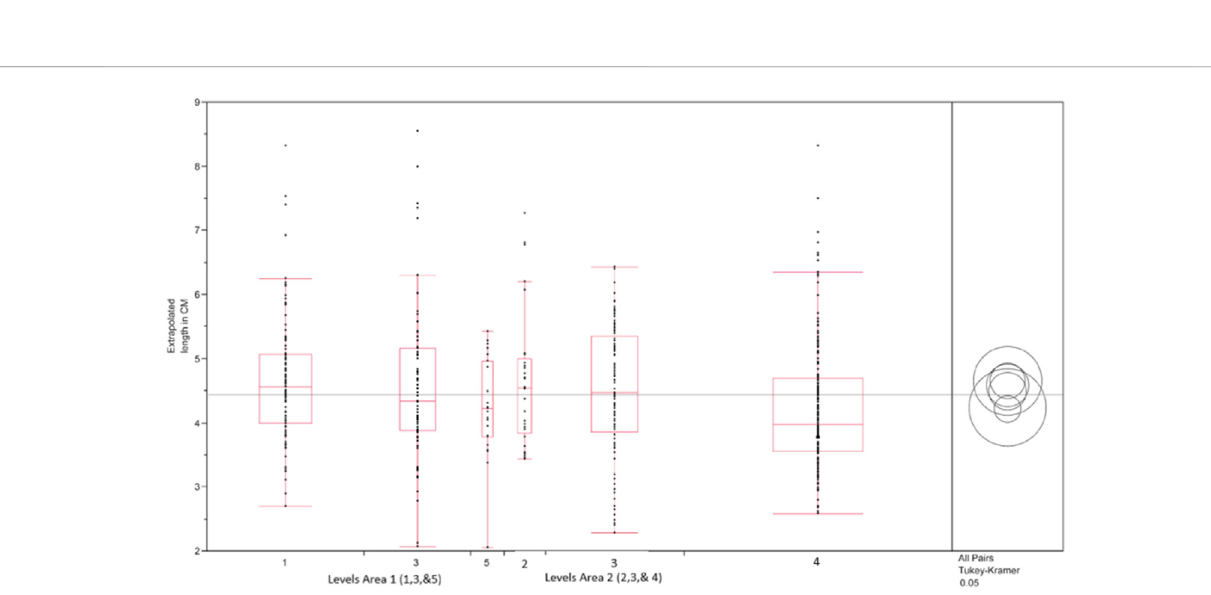
Frontiers in Earth